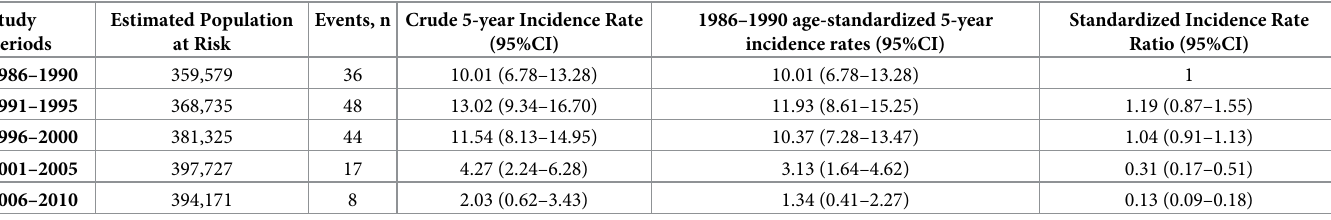
Table 3 compares the characteristics of HAM/TSP patients with a disease onset in 1986– 2000 and in 2001–2010.